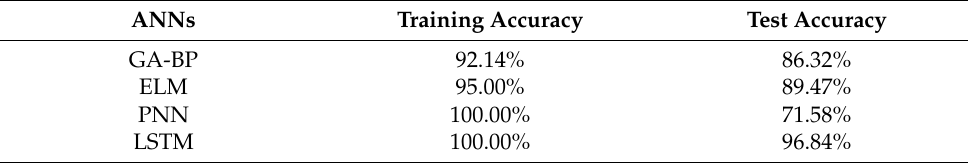
Table 2. Classification accuracy of training sets and test sets from ANN models.